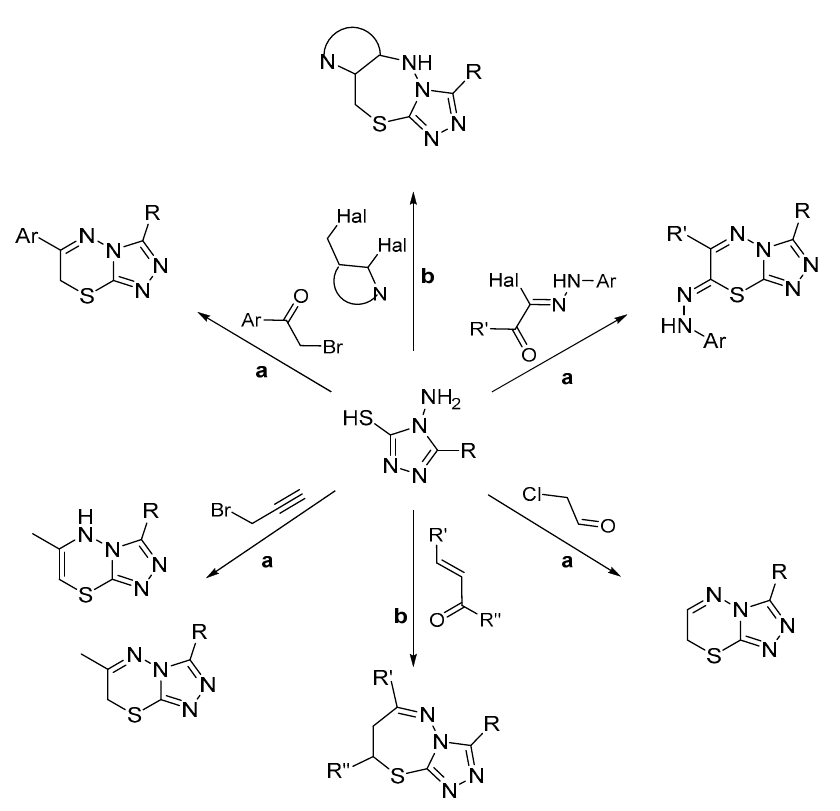
Figure 3. The most common synthetic routes for target compounds: ( a ) [1,2,4]triazolo[3,4- b ][1,3,4]thiadiazines and ( b ) [1,2,4]triazolo[3,4- b ][1,3,4]thiadiazepines.